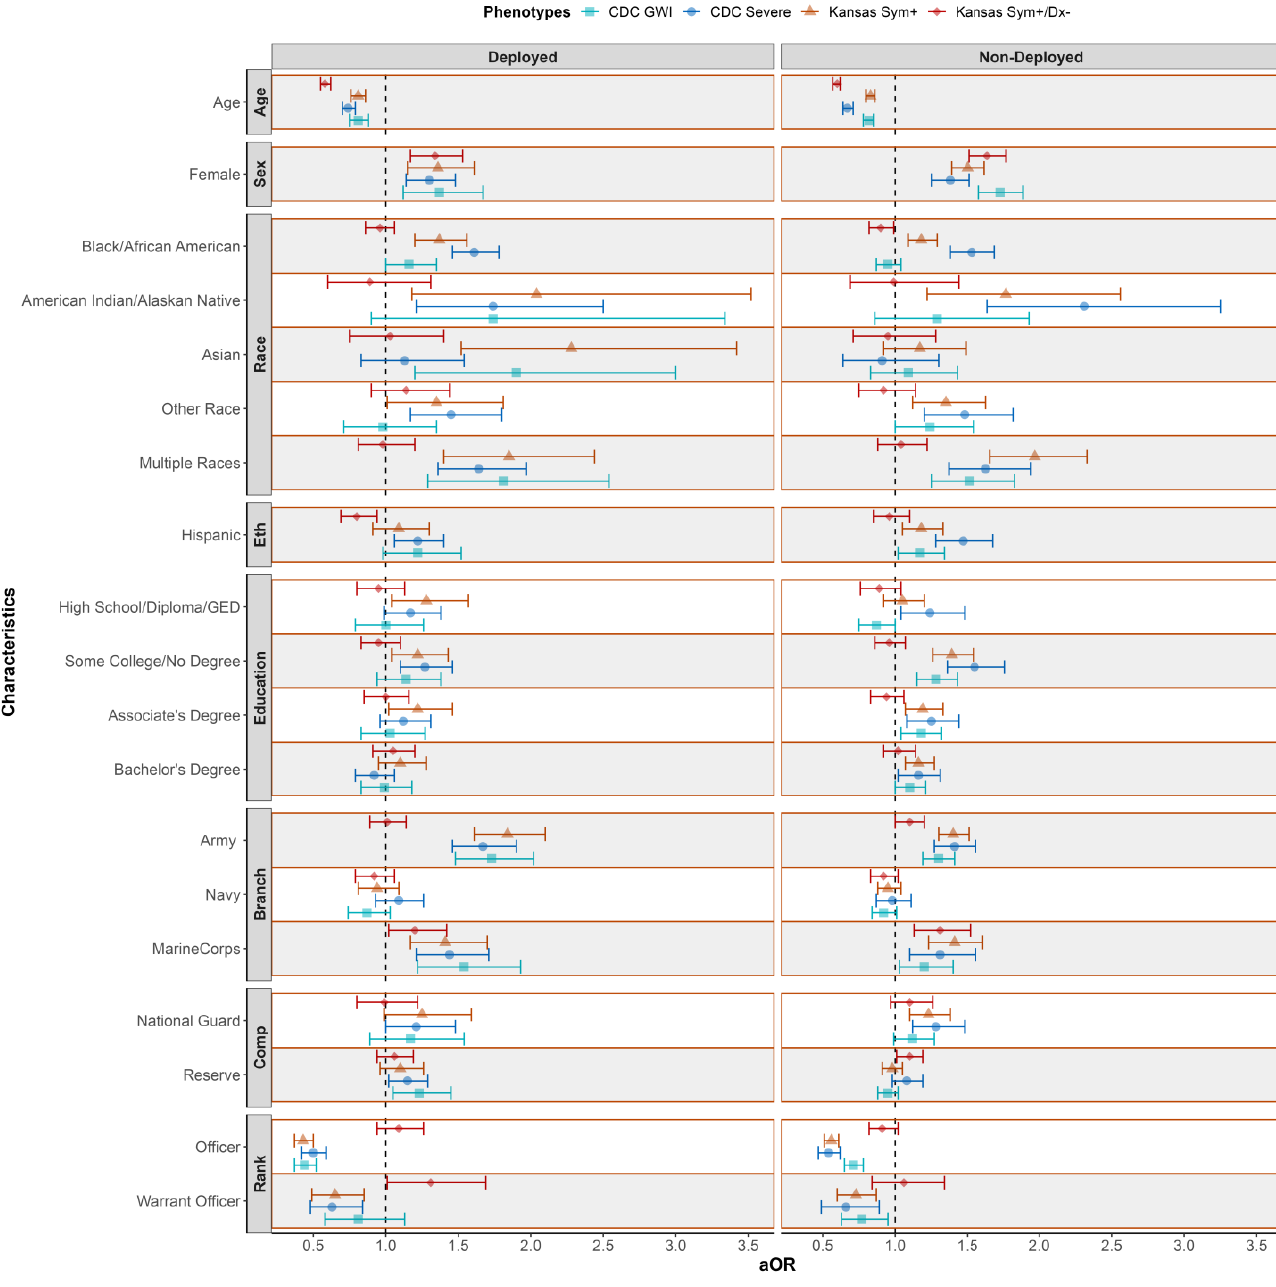
Figure 2. Adjusted Associations of Gulf War Illness Phenotypes with Demographic Characteristics Stratified by Deployment Status. Legend: Reference groups include male, white, non-Hispanic, ≥ master’s degree, Air Force, Active Duty, and Enlisted. CDC = Centers for Disease Control and Prevention, GWI = Gulf War Illness, Kansas Sym+ = Kansas Symptoms, Kansas Sym+/Dx − = Kansas (symptoms and no exclusionary conditions), Eth = ethnicity, Branch = service branch, comp = unit component and aOR = adjusted odds ratio. Adjusted for age (as a continuous variable in the model with odds ratios calculated for 10-year increase in age), sex, race, ethnicity, education, service branch, rank, and unit component. Statistically significant if 95% confidence interval does not include 1.00 aORs are derived from eight models, two (deployed and non-deployed) for each GWI phenotype (KS Sym+, KS Sym+/Dx − , CDC GWI and CDC Severe GWI). Data are from the Department of Veterans Affairs’ (VA) Cooperative Studies Program 2006/Million Veteran Program (MVP) 029 cohort, Genomics of GWI (VA CSP 2006/MVP 029 Project) with a total study population size of 35,902; 13,107 deployed and 22,795